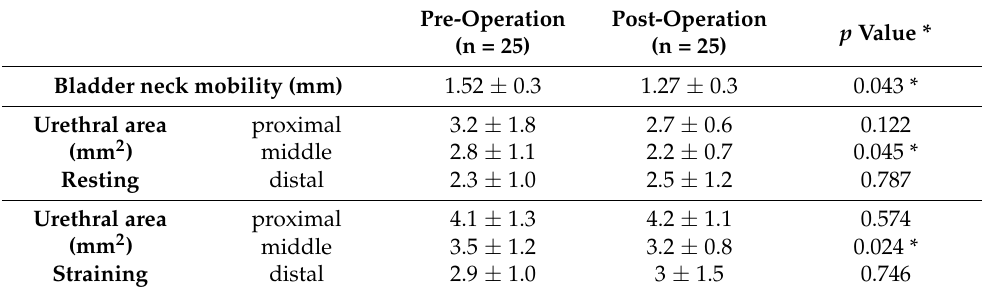
Table 4. Urethral topography at baseline and 6 months after treatment during resting and straining.